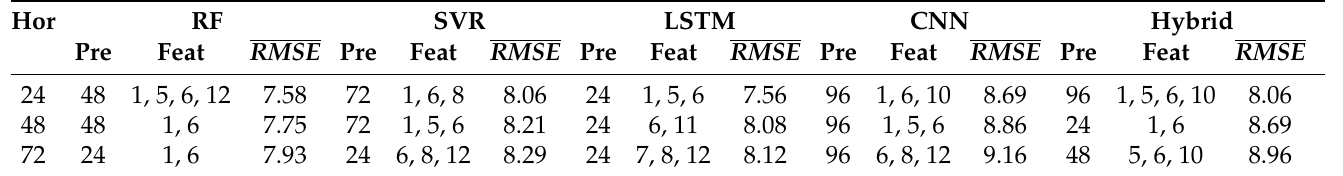
Table 4. Best ML-method Configuration &